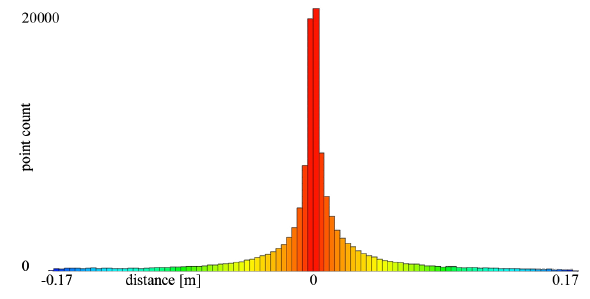
Figure 6. Result of ICP matching in RiScan showing